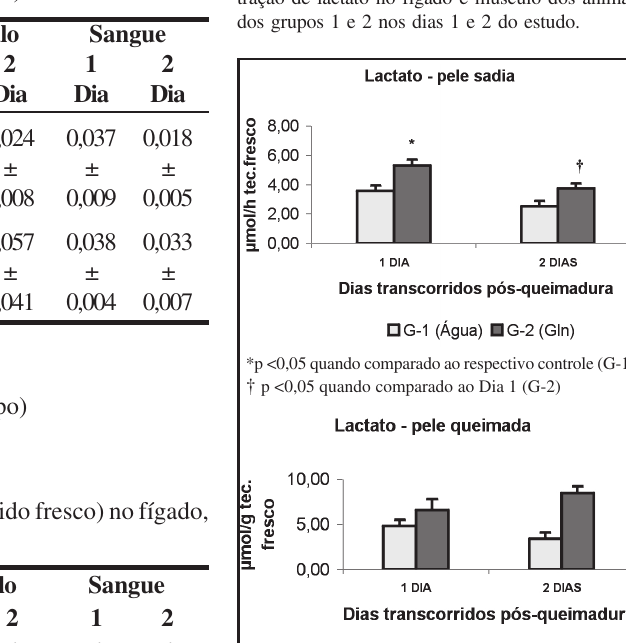
FIGURA 2 – Representação gráfica da concen- tração de lactato no fígado e músculo dos animais